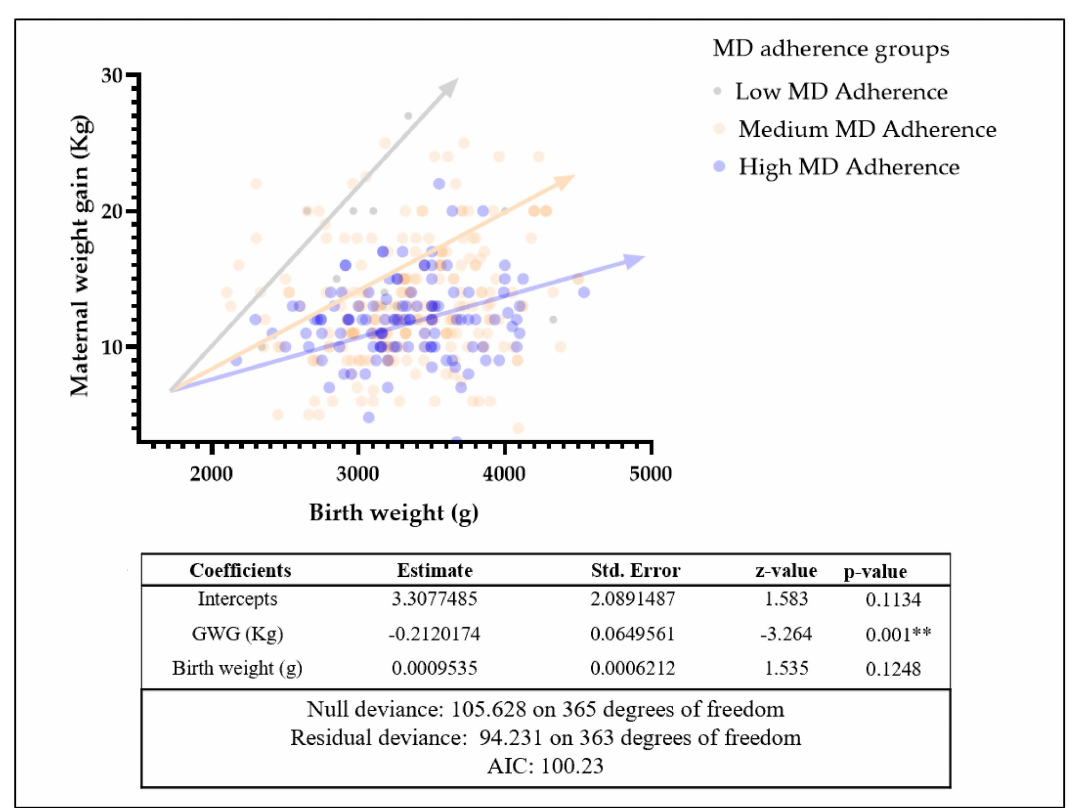
Figure 4. General linear model (GLM) for MD adherence groups on maternal weight gain and birth weight in healthy groups. Statistical significance was attributed as ** p <